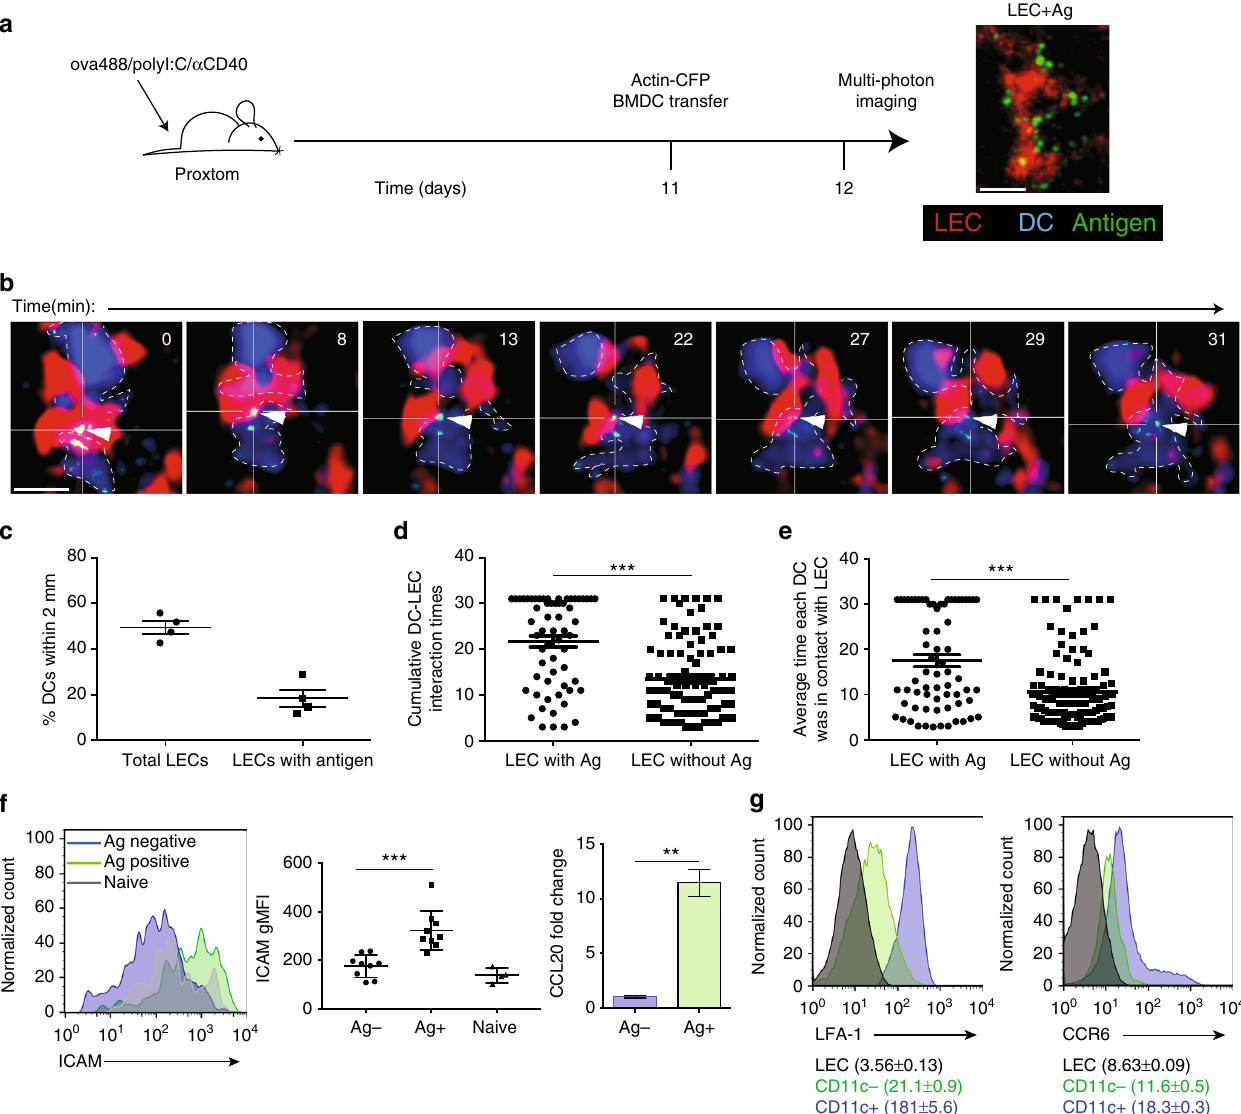
Fig. 2 DCs interact with antigen-bearing LECs. a schematic of experimental design and antigen-bearing LEC, where LEC is red and antigen is green. Scale bar on image is 10 μ m. b Still images from movie demonstrating prolonged association of DC-blue with white dashed outline, with antigen-green with white triangle and LEC-red. Scale bar on images is 15 μ m. See Supplemental Movies for other examples. c Graph demonstrating the percentage of DCs within 2 μ m of total LECs or only LECs that have antigen. Each dot represents the average from an individual lymph node. d Quantitation of DC – LEC cumulative interaction times from c . Analysis evaluated the duration that each DC interacted with each LECs that did or did not have antigen. e Quantitation of DC – LEC average interaction time. Analysis evaluated the average length of each interaction between DC and LEC. Seven-time lapse movies from four lymph nodes were imaged and quanti fi ed using IMARIS and Matlab software. f ICAM1 and CCL20 expression by antigen+ LECs compared to antigen — LECs 2 weeks after immunization. g Expression of C-C chemokine receptor (CCR6) and lymphocyte function-associated antigen – 1 (LFA-1) on bone marrow-derived DCs grown for 6 days in GM-CSF. Statistical analysis was done using an unpaired t -test with a p -value of < 0.0001. Error bars represent mean ± standard error of the